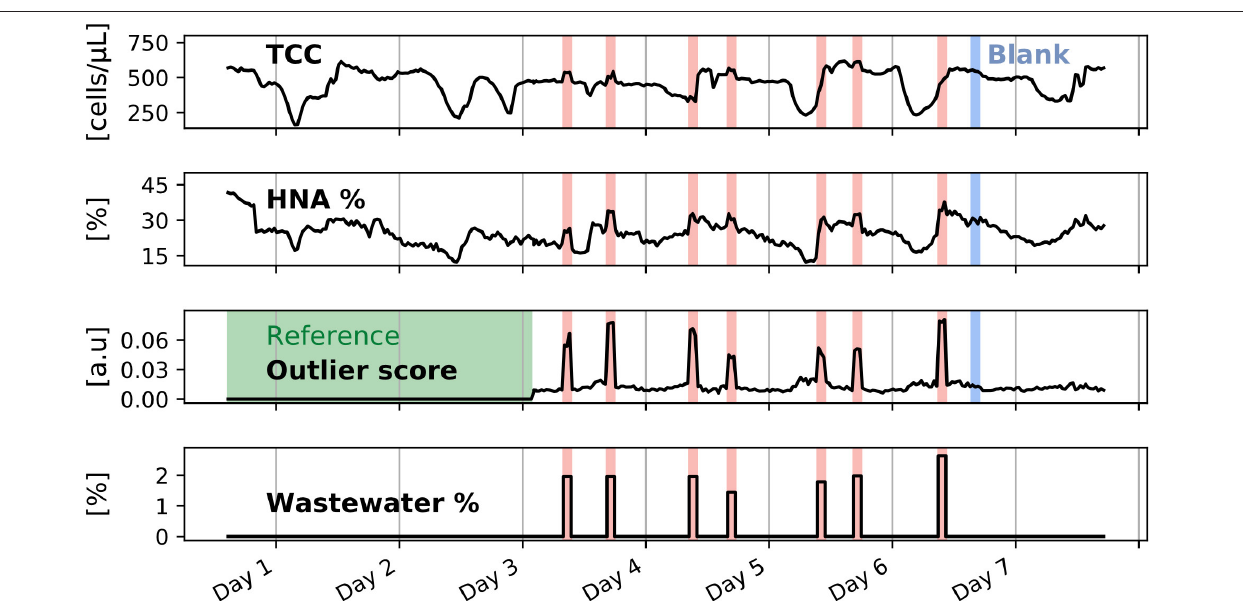
FIGURE 5 | Flow cytometric quality parameters and outlier score after a monitoring time of 1 week. A reference period over 2 and half days was defined, shown as a green shaded area, on which the MCCD model was initialized. Four days of intermittent wastewater spiking were performed, shown here as red shaded areas. During the wastewater spikes, the outlier score signal peaks due to the change in the microbial community. One blank spike with tap water was performed at the end of the online monitoring period and is shown by the blue shaded areas. The blank spike did not affect the amplitude of the outlier score